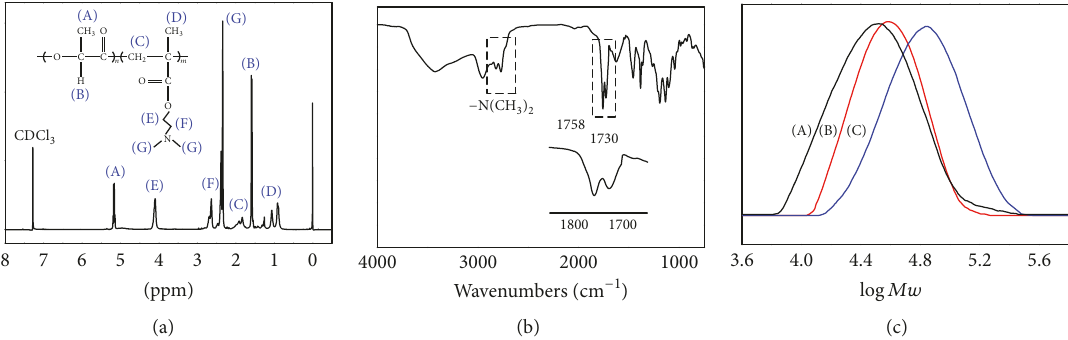
Figure 7: (a) 1 H NMR spectrum in CDCl 3 and (b) FTIR spectrum of PLA 345 -PDMAEMA 213 block copolymers. (c) Evolution of GPC traces of the synthesized PLA 345 -PDMAEMA block copolymers with polymerization time of 1 (A), 3 (B), and 10 h (C).